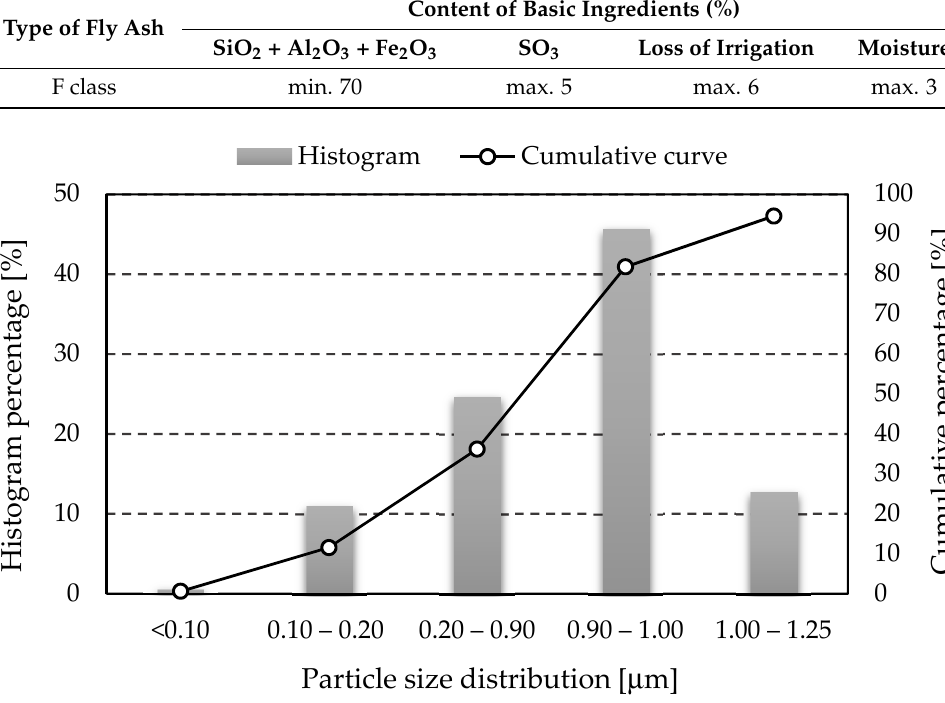
Figure 1. Histogram of particle size distribution and cumulative particle size distribution curve for the fly ash used in investigation.